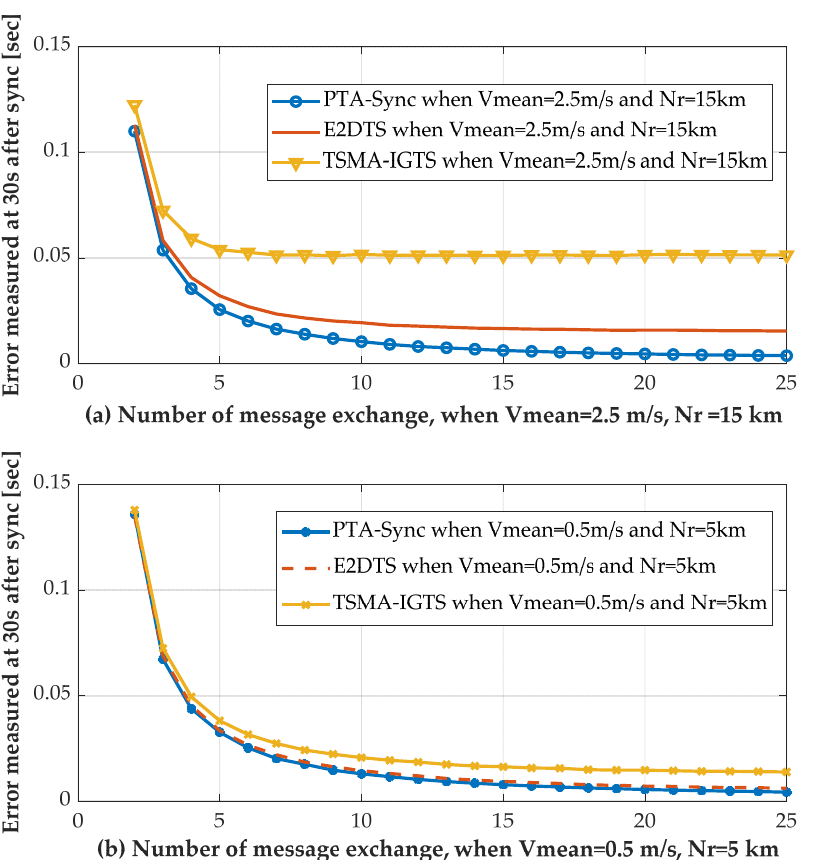
Figure 5. Time error measured at 30 s after synchronization versus N_ex when I_tx = 1.2 s, T = 30 s, α = 0.5.